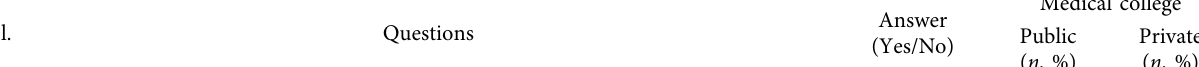
people just like you?